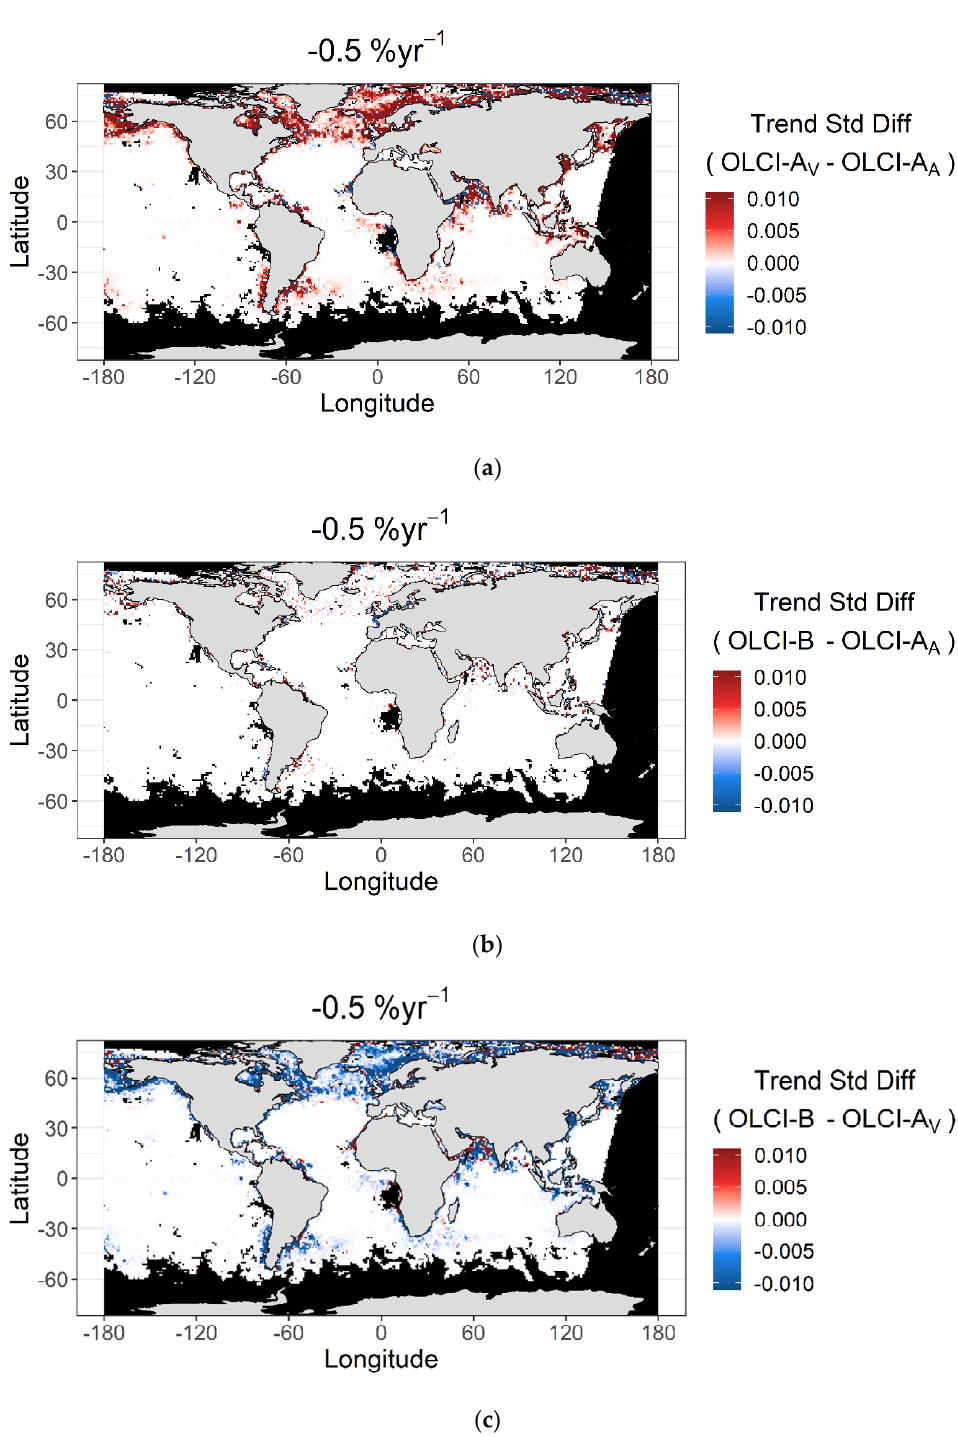
Figure 4. Global maps at 1 ◦ resolution of the di ff erences between the standard deviation of all chl- a trend estimates from all bootstraps for an input trend of − 0.5% · yr − 1 for ( a ) OLCI-A-Aligned and OLCI-A-Vicarious, ( b ) OLCI-A-Aligned and OLCI-B, and ( c ) OLCI-A-Vicarious and OLCI-B in each grid cell. Red indicates that the former dataset in each pair has higher standard deviation of chl- a trend estimates than the latter dataset in each pair. See Appendix B for similar maps for all input trends. If statistical testing determined that the di ff erence in the variance of chl- a trend estimates between the two datasets was not significant (Appendix C) the cell is considered as having a di ff erence of zero (i.e., white). Black grid cells indicate where missing data prevents analysis.